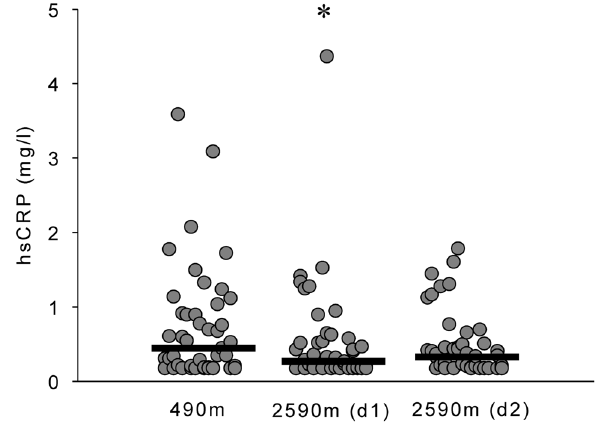
Figure 4. Effects of moderate altitude on C-reactive protein. Scatterplot showing individual highly sensitive C-reactive protein (hsCRP) blood levels in Zurich (490 m) and Davos Jakobshorn (2590 m). Black lines represent medians. HsCRP levels were lower on day 1 at 2590 m compared to 490 m. *p , 0.05 vs 490 m.